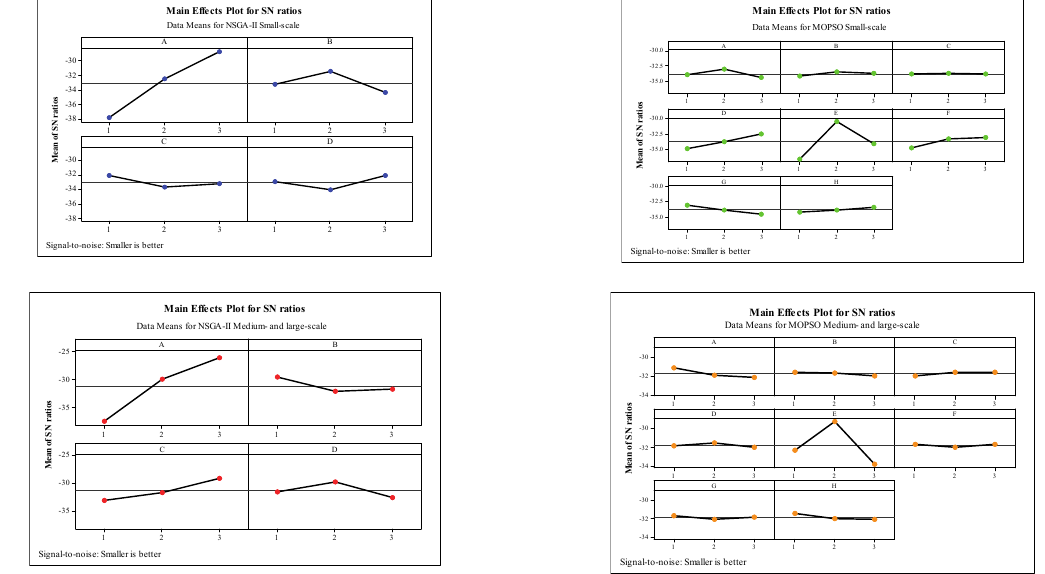
Fig. 9 Signal to noise charts by the Taguchi method